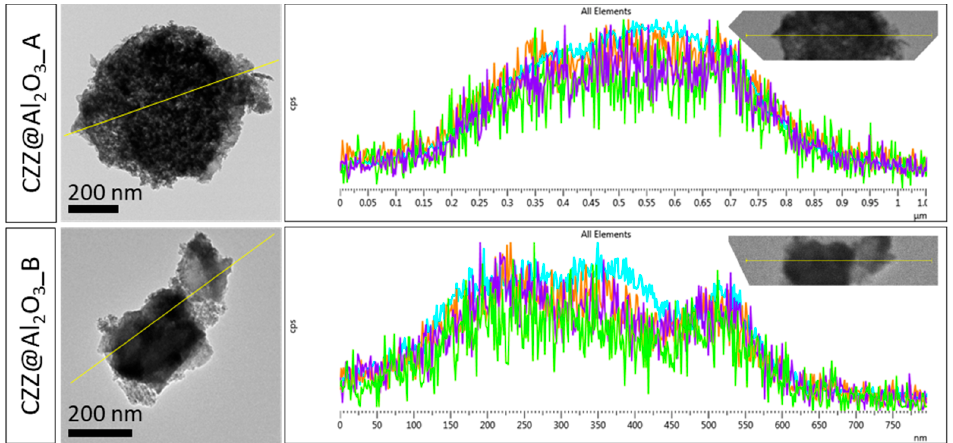
Figure 5. TEM-EDX linear profile of CZZ@Al 2 O 3 _A (upper part) and CZZ@Al 2 O 3 _B (lower part).